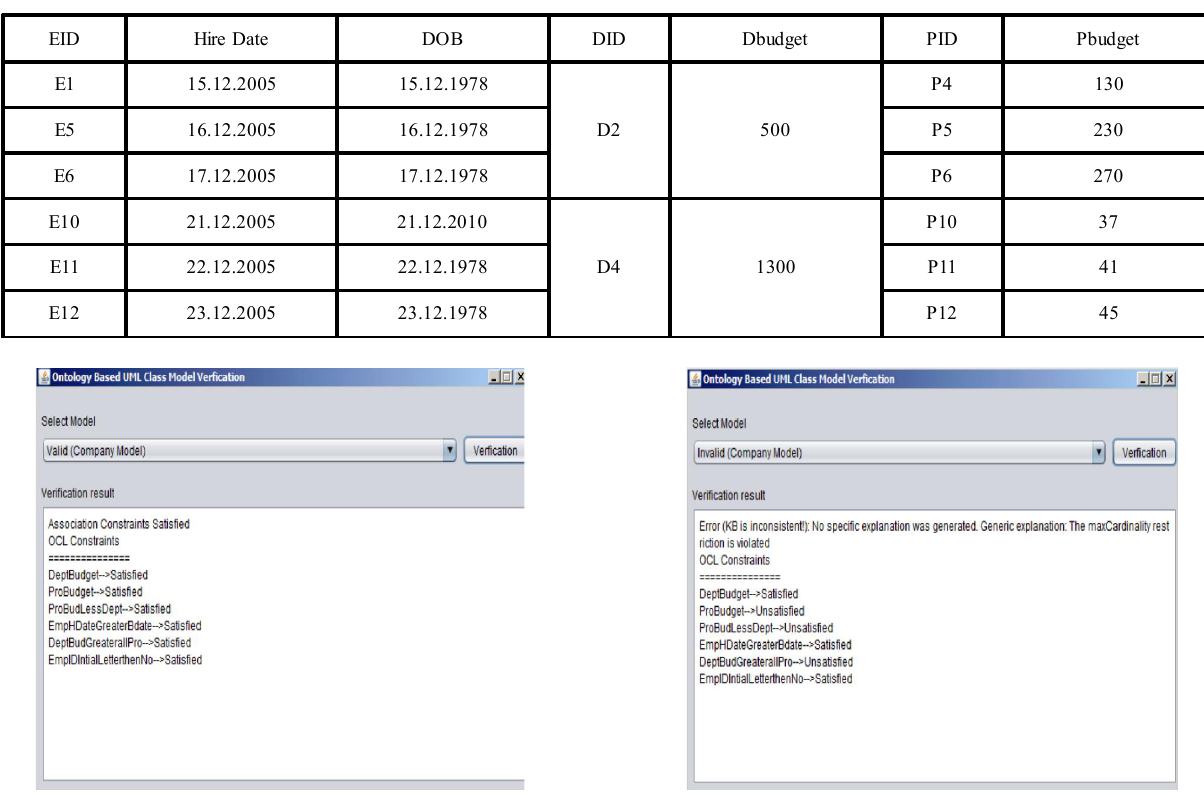
TABLE 9. INVALID PROPERTIES SETTING FOR COMPNAY MODEL